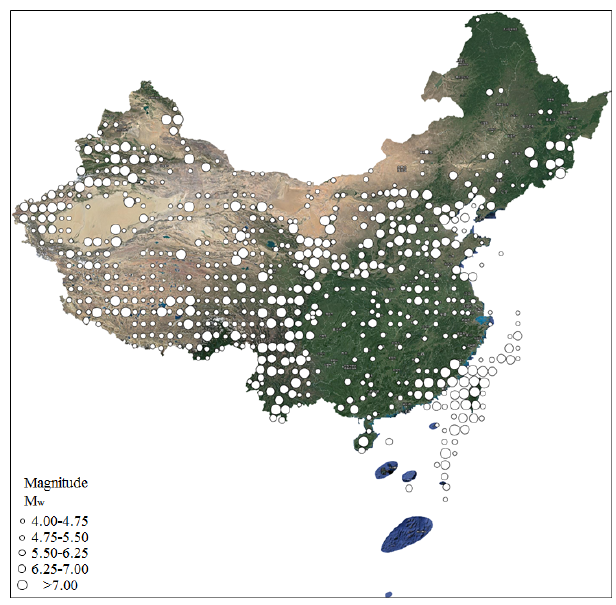
Figure A4. Earthquakes in China, year 1831 BC to 1969 AD (developed from Ref. [38]).